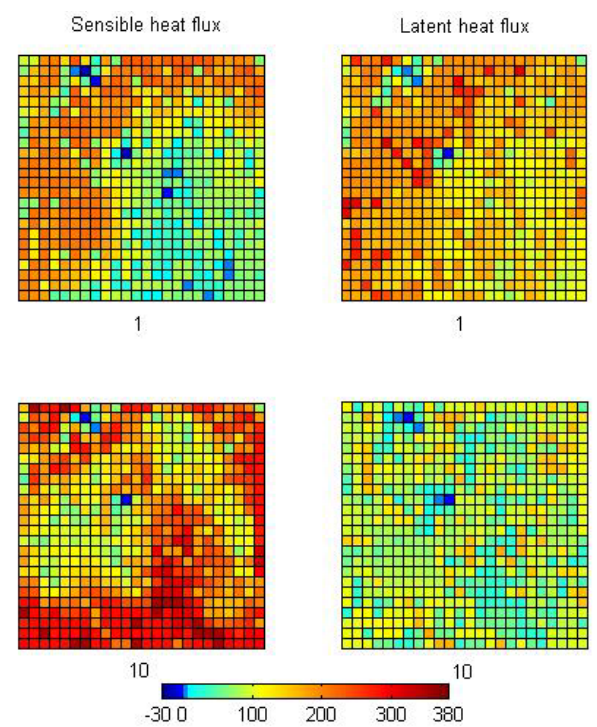
Figure 10. The simulated sensible ( left ) and latent heat fluxes ( right ) for the first and last day of the 10-day period (numbered 1 and 10). Values are for noon each day.